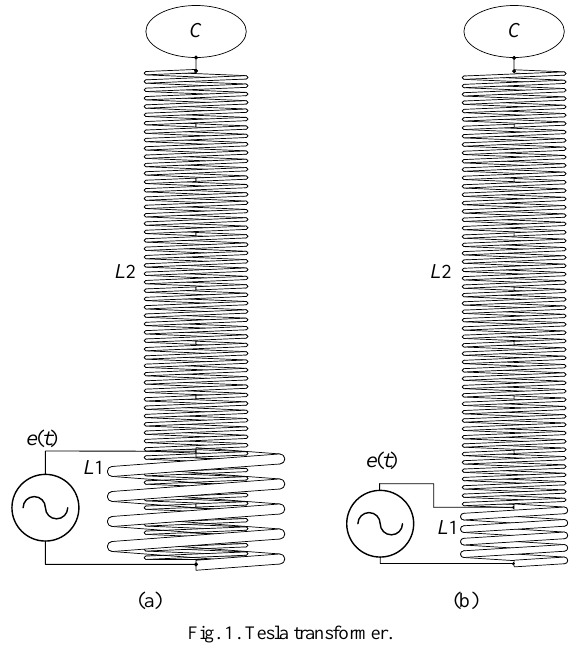
Fig. 1. Tesla transformer.